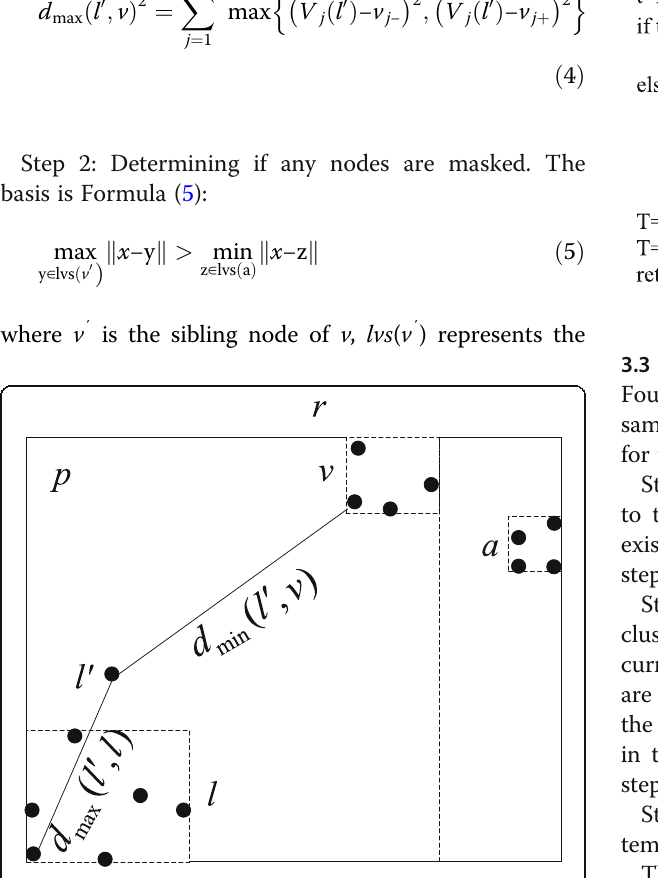
Fig. 5 Optimized method of inserting new